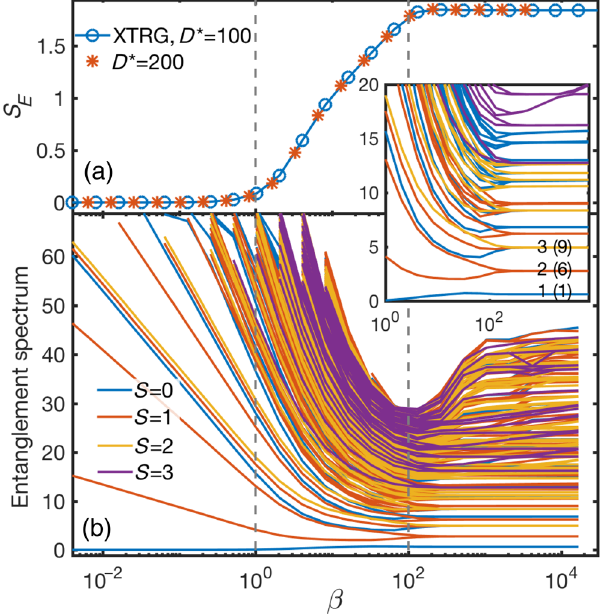
10. (a) Bipartite MPO entanglement entropy S E across the center of the system of a spin- 1 = 2 Heisenberg chain (length L ¼ 100 , OBC). (b) Entanglement spectra obtained in the center of the system versus a wide range of temperatures presented as an RG flow in energy scales, where lines from the same symmetry sectors, i.e., S ¼ 0 ; 1 ; 2 ; … , are plotted in the same color. Vertical markers depict different temperature regimes (see text). The inset enlarges the region around β ¼ 100 , and the labels d (cid:3) ( d ) indicate the degeneracy in the RG fixed point ES in terms of individual multiplets (or states),